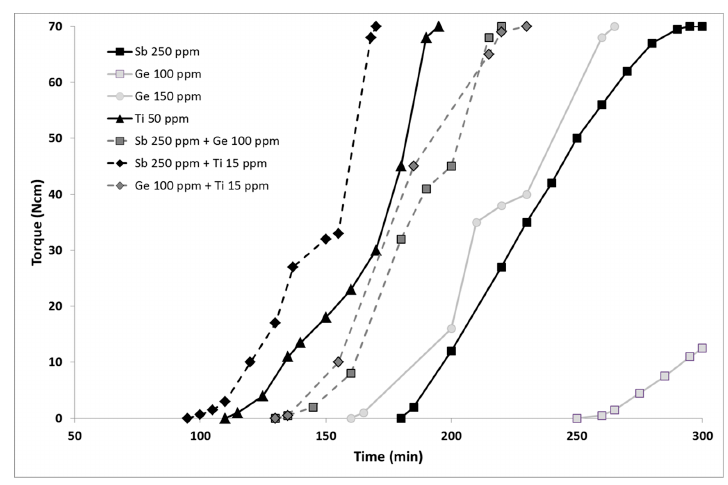
Figure 2. Evolution of the torque as a function of the reaction time. Table 1. Kinetic results, microstructure, reduced viscosity and molecular weights of PEIT formed using the different catalysts.